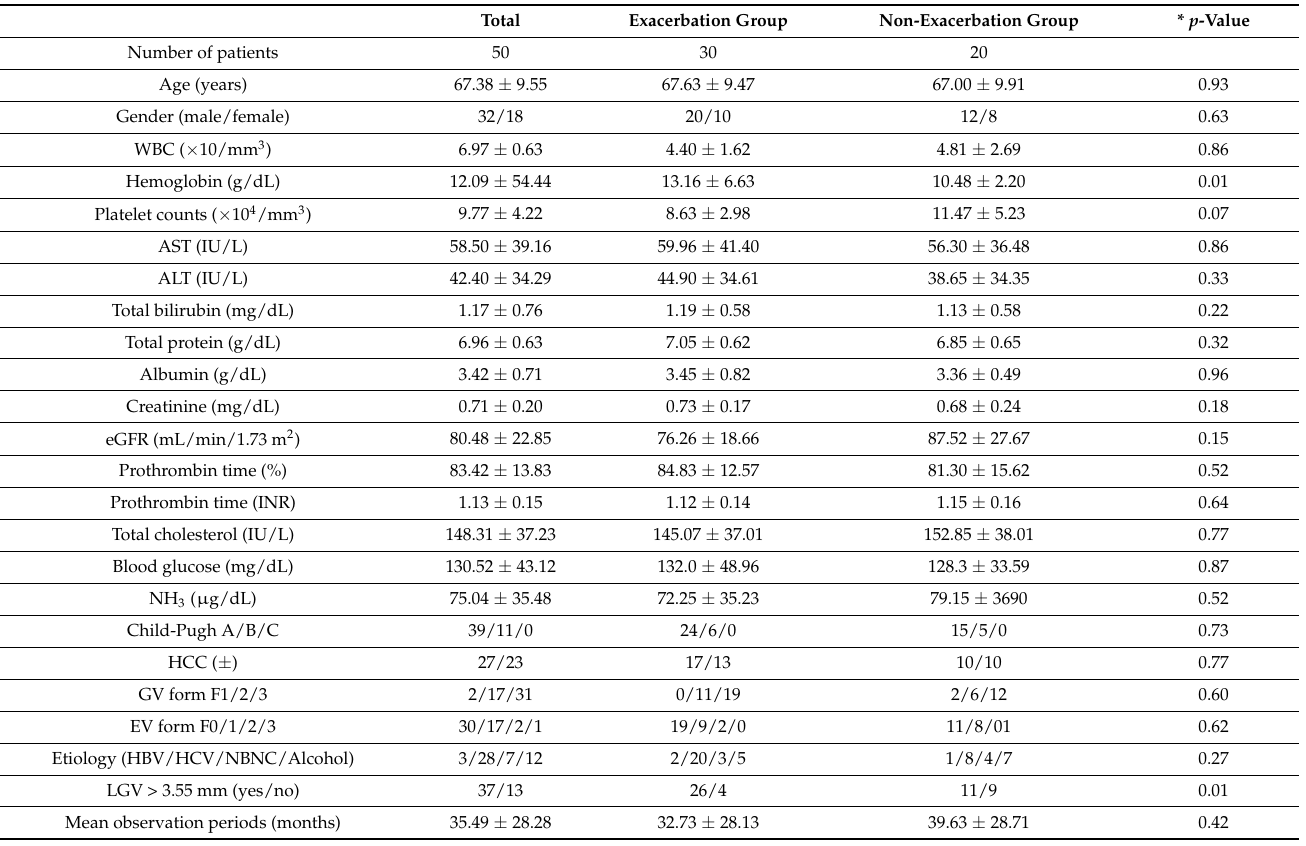
Table 1. Comparison of patients’ background between the esophageal varices exacerbation and non-exacerbation